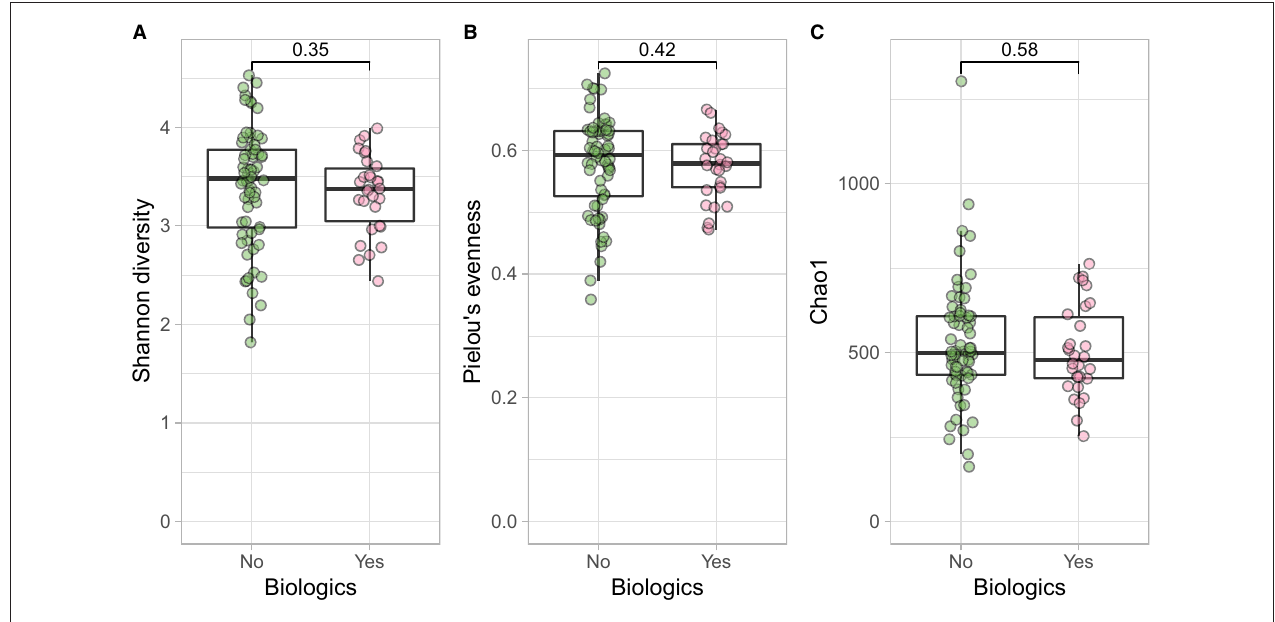
FIGURE 5 | CD participants- microbial α diversity and treatment modalities. Measures of microbial α diversity between treatment options in CD group (Comprising remission and relapse) including: (A) Shannon’s index (diversity); (B) Pielou’s evenness; and (C) Chao1 index (richness). Analysis did not show any significant differences between the two groups over